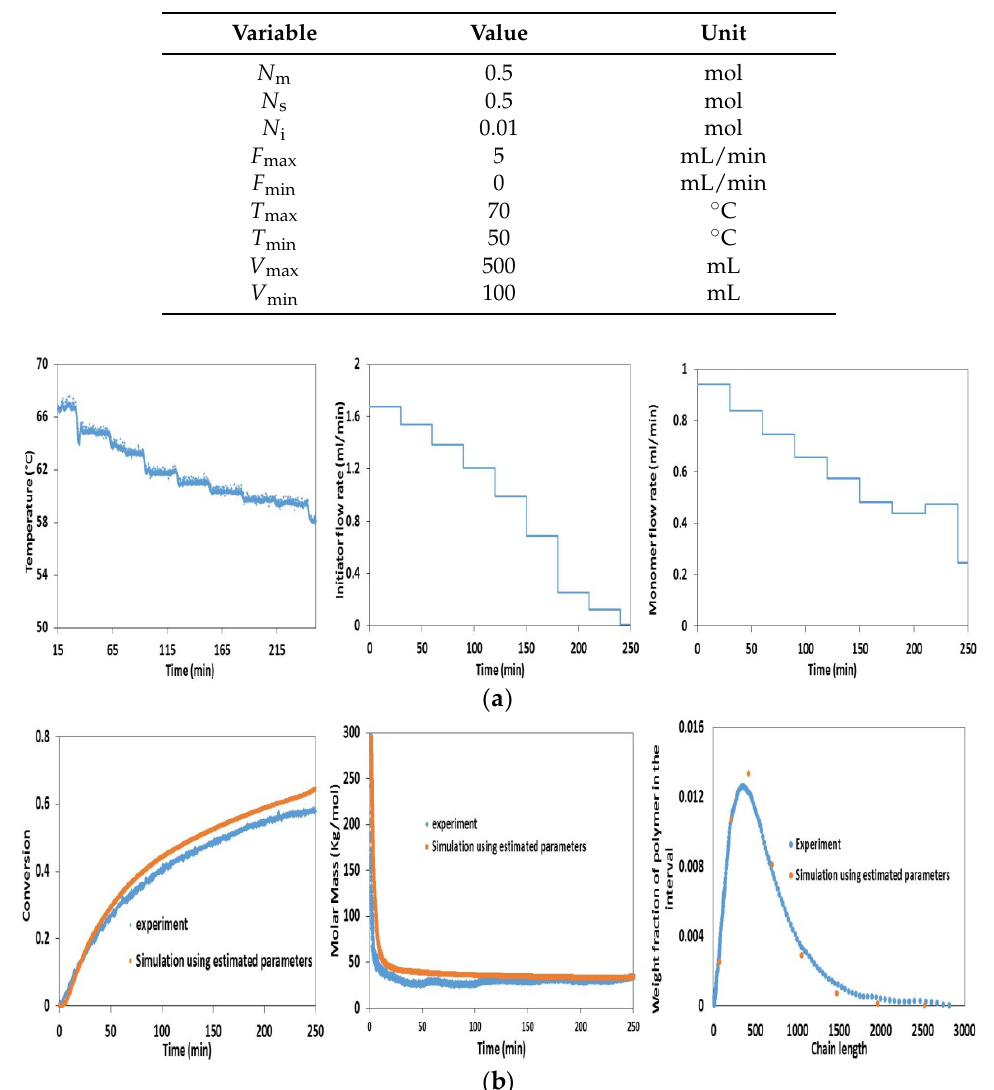
Table 5. Values of optimization constraints parameters.